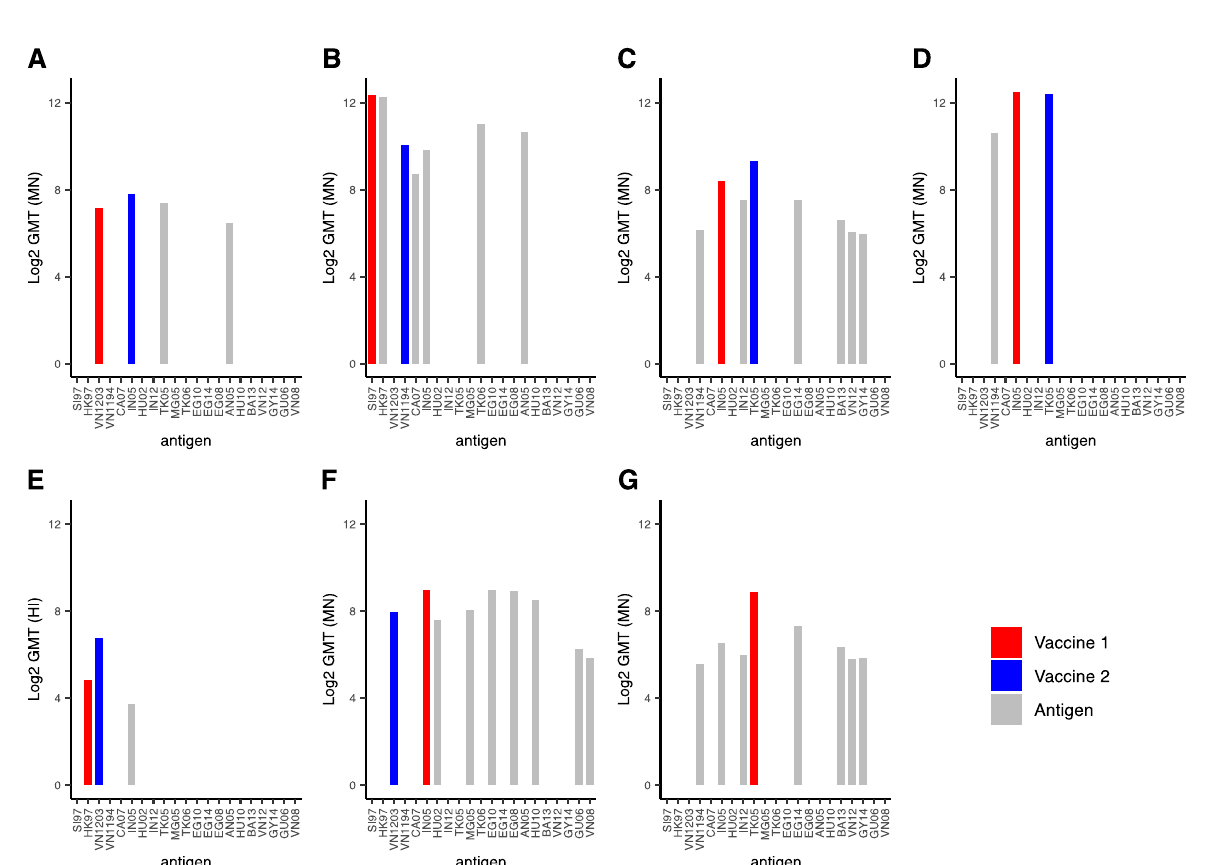
Figure 5. Geometric mean titers obtained against various antigens after homologous or heterologous vaccination regimens. The data in each panel were derived from one of the six articles in which a heterologous vaccination regime was assessed and immunological endpoints against one or multiple antigens heterologous to the vaccine antigens were reported. For each study, the experimental group and time points yielding the highest geometric mean titers are displayed. In case immunological endpoints were not assessed against a particular antigen, no bar is depicted. Bars indicating titers against the primary vaccine, secondary vaccine and heterologous strains are red, blue and grey respectively. ( A ) data obtained from Erlich et al., 2009 [48]; ( B ) data obtained from Khurana et al., 2014 [47]; ( C , G ) data obtained from Levine et al., 2019 [44]; ( D ) data obtained from Risi et al., 2011 [40]; ( E ) data obtained from Goji et al., 2008 [49]; ( F ) data obtained from Haveri et al., 2021 [54]. In panel ( G ), the homologous vaccination regime counterpart of panel ( C ) is displayed for direct comparison. Abbreviations: GMT: geometric mean titer, MN: microneutralization, SI97: A/duck/Singapore/1997 (clade C), HK97: A/Hong Kong/156/1997 (clade 0), VN1203: A/Vietnam/1203/2004 (clade 1), VN1194: A/Vietnam/1194/2004